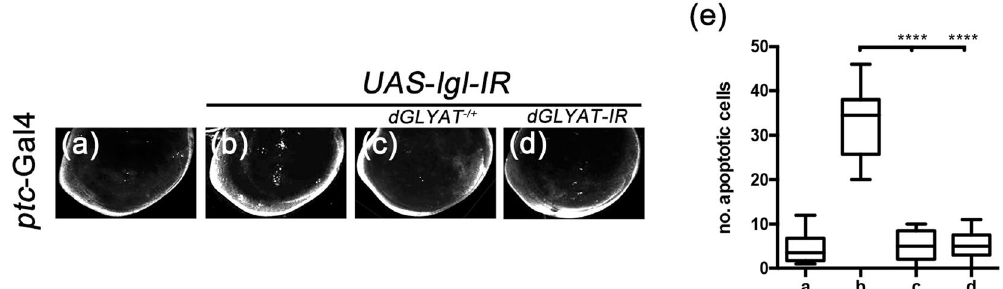
Figure 8. d GLYAT modulates loss of lgl -induced cell death in wing discs. Light micrographs of Drosophila wing discs are shown. Compared with the ptc -Gal4 control ( a ), depletion of lgl induces cell death along the A/P boundary ( b ), which is suppressed by mutation ( c ) or RNAi-mediated depletion ( d ) of dGLYAT . ( e ) Statistics of the AO positive cell numbers in ( a–e ) (a, n = 6; b, n = 10; c, n = 13; d, n = 7). **** P <